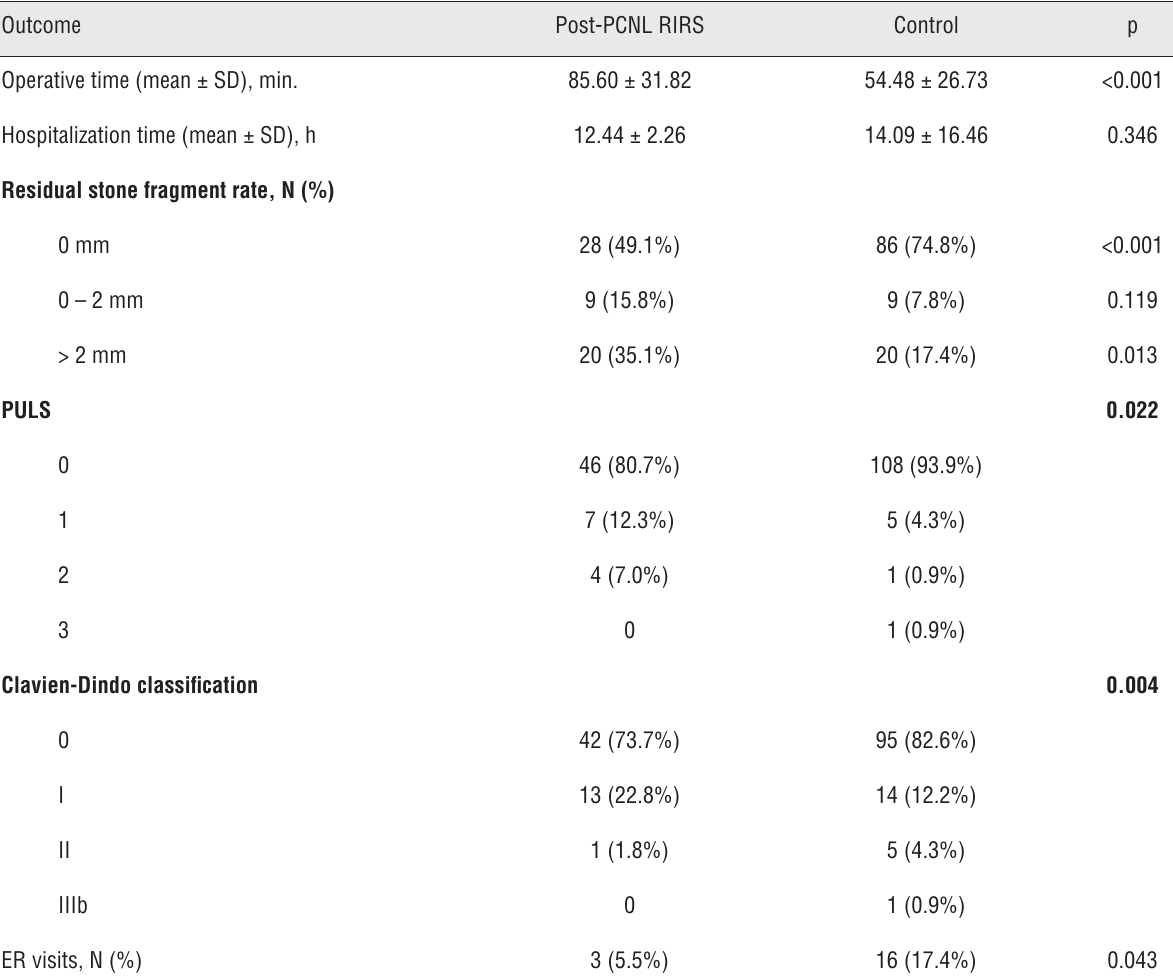
Table 2 - Outcomes of post-PCNL RIRS vs.